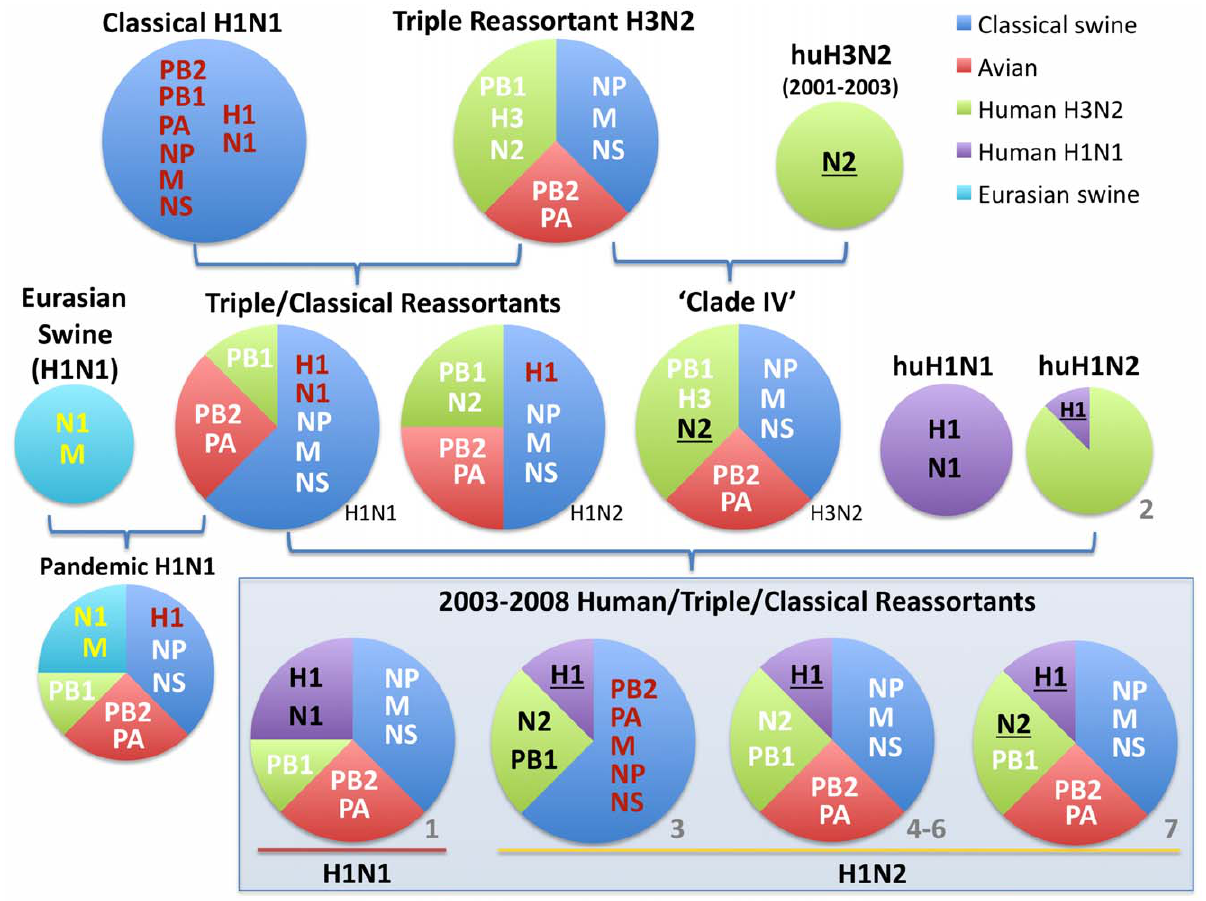
Figure 1. Evolutionary origins of H1 swine influenza viruses in North America. Circles are color-coded according to the evolutionary origins of the 8 segments that comprise the viral genome (PB2, PB1, PA, HA, NP, NA, M, and NS): blue = classical swine influenza virus, red = avian influenza virus, green = human H3N2 influenza virus, purple = human (seasonal) H1N1 influenza virus, and light blue = Eurasian avian-origin H1N1 swine influenza virus. The shading and underlining of letters provides additional indication of whether a particular segment is descended from the 1998 triple reassortant swine viruses (white), classical swine influenza viruses (red), or Eurasian swine influenza viruses (yellow). The ‘2003–2008 Human/ Triple/Classical Reassortant’ viruses represent those characterized in this study (Table 1, Figs. 3 and 4). The numbers in gray (1–7) and all color codes correspond to those used in Table 1 and Figs. 3 and 4, with additional bold black shading and underlining of H1 and N2 segments included to show evolutionary linkages in cases where evolutionary origins may otherwise be ambiguous. Asterisks represent novel reassortment events identified in this study.